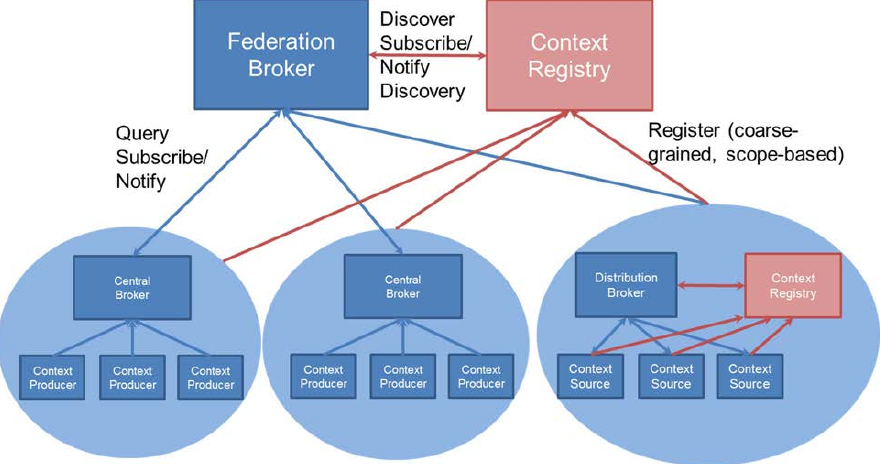
Figure 3. Federated broker architecture